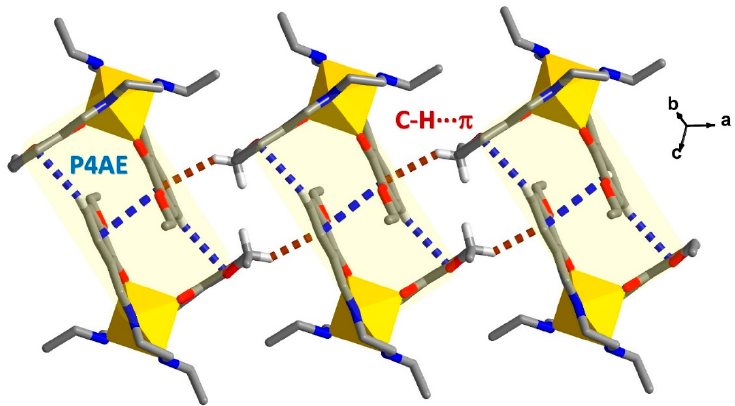
Figure 5 . The 1D chain packing motif in 3 and 4 involving P4AE [8] and C–H··· π interactions. Colour coding: O, red; N, blue; C, grey; H, white; yellow octahedra show coordination environment around Fe.